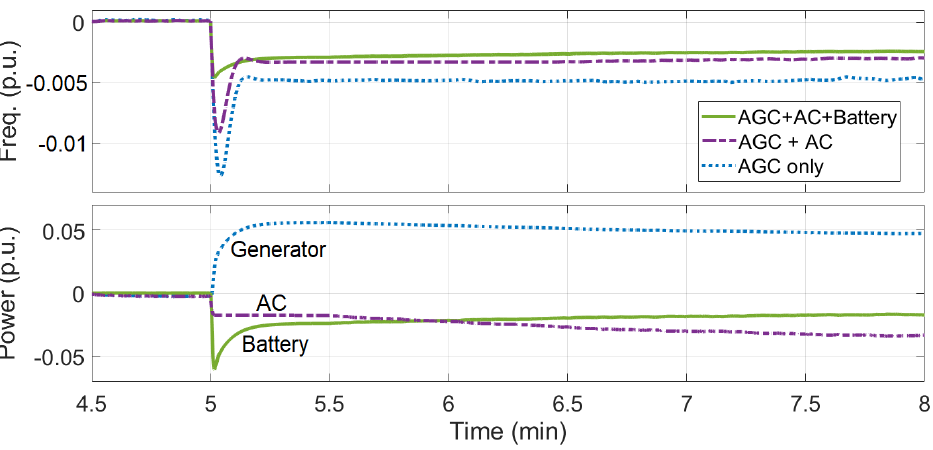
Figure 18. Response of generator, AC, and battery system to 10% step increase in load.